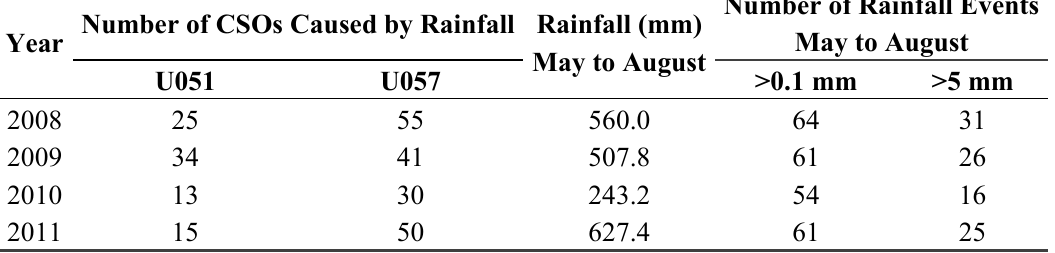
Table 1. Number of combined sewer overflows (CSOs) for the two combined overflow units and rainfall data for each season (from 1 May to 31 August).